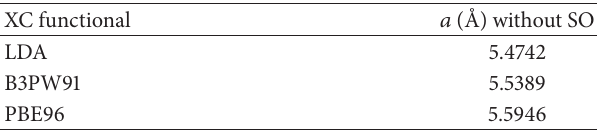
Table 1: Lattice parameters for 𝛿 -Bi 2 O 3 calculated in this work. The experimental value a is 5.525